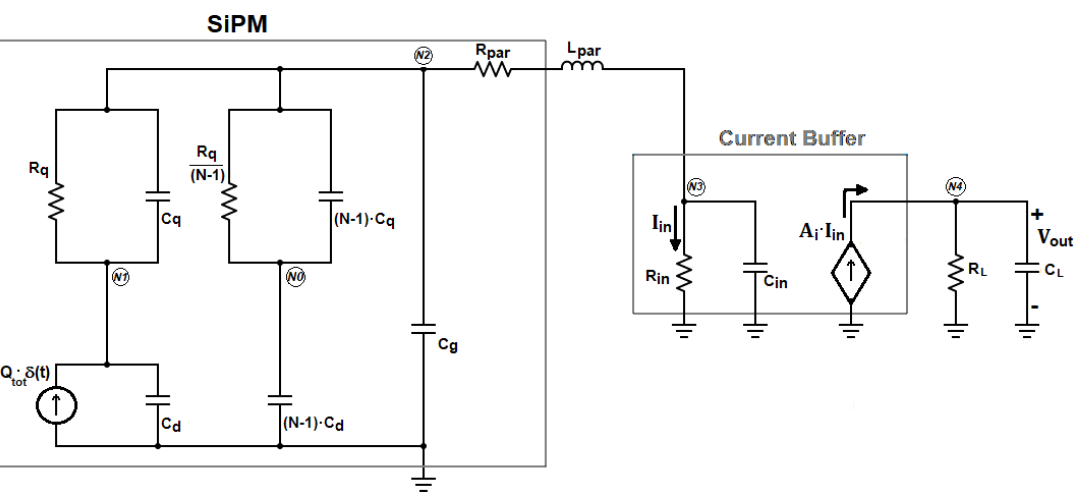
Figure 1. Equivalent electrical model of the silicon photomultiplier (SiPM) coupled to a current-mode front-end.